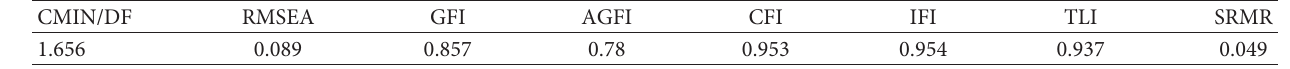
Table 8: Overall fit index calculation.